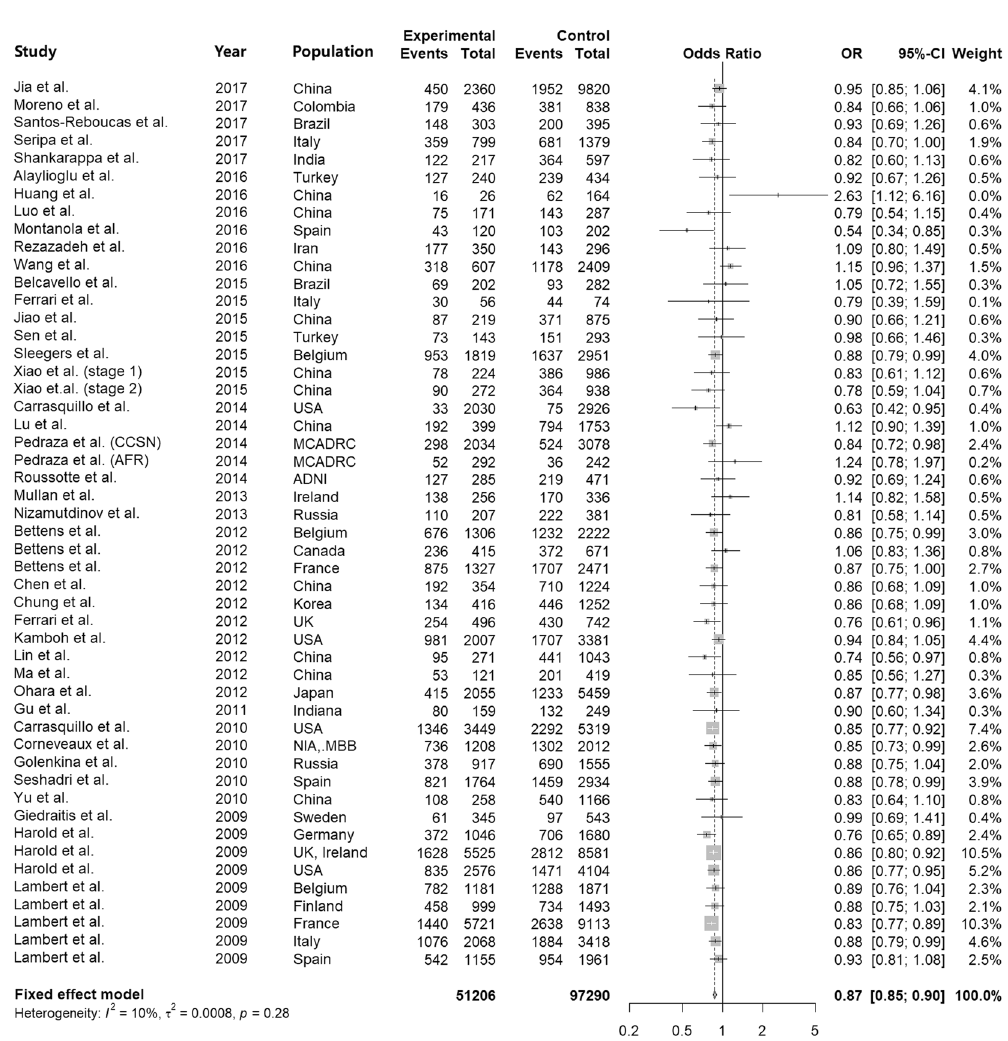
Figure 2. Forest plot for the meta-analysis of rs11136000 polymorphism using allele model. All the 50 selected studies are used to meta-analysis of the allele contrast (T versus C) by the fixed effect model (Mantel-Haenszel) because the genetic heterogeneity is not significant. The minor allele (T) of rs11136000 was significantly associated with a decreased risk of